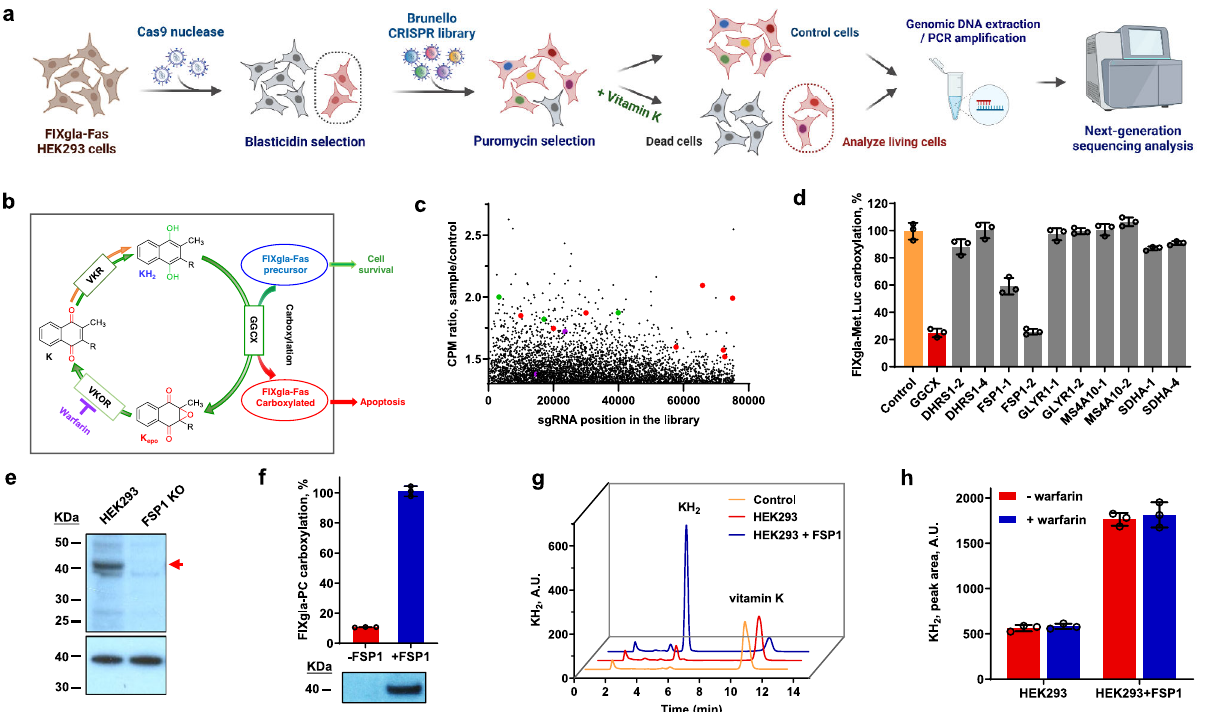
Fig. 2 | Genome-wide CRISPR-Cas9 knockout screening of warfarin-resistant VKR. a Schematic diagram of genome-wide loss-of-function screening using Bru- nello lentiviral library with FIXgla-Fas/HEK293 reporter cells. This fi gure was cre- ated with BioRender.com. b Scheme of VKD carboxylation of reporter protein FIXgla-FasbythevitaminKredoxcycle.Apoptosisofreportercelloccursonlywhen the reporterproteinFIXgla-Fasiscarboxylated. c ScatterplotofsgRNAenrichment after VKD apoptotic functional screening. Red dots, Fas-associated apoptosis pathwayassociatedproteins;greendots,calcium-dependentproteins;purpledots, GGCX. d Cell-basedvalidationofthecandidategenesforvitaminKreductioninthe presence of warfarin. Lentivirus containing Cas9 and selected sgRNA were trans- duced into FIXgla- Met .Luc/HEK293 reporter cells. After puromycin selection for 7days,survivalcellswereincubatedwith11 µ MvitaminKand5 µ Mwarfarinfor24h. Carboxylationef fi ciencyof thereporter protein FIXgla- Met .Lucwasdetermined by luminescence ELISA. VKD carboxylation ef fi ciency of non-targeting sgRNA trans- fected cells was normalized to 100%. e Immunoblotting of HEK293 cells and these cells with their fsp1 gene knocked out (FSP1 KO). Top panel: probed by anti-FSP1